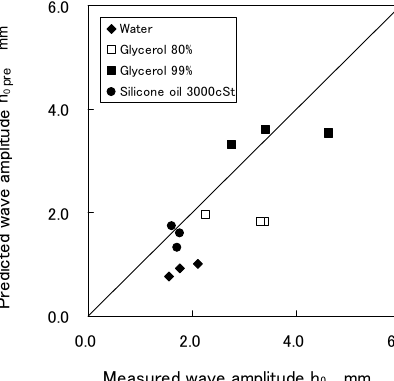
Fig.9 Prediction of wave